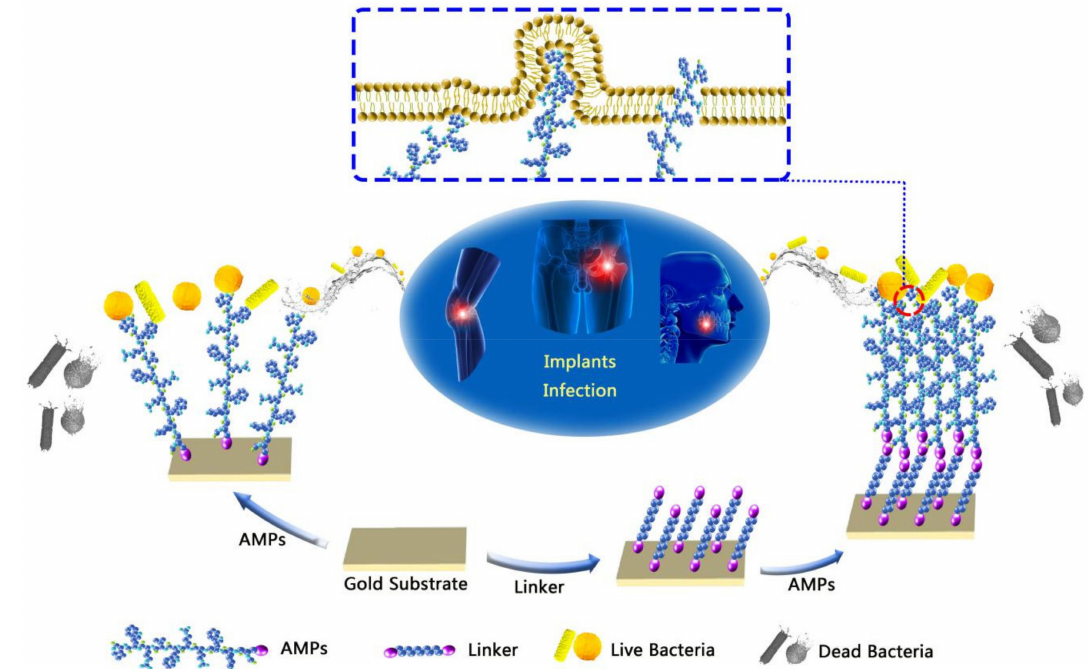
Figure 1. Schematic diagram of the structure of the AMPs and self-assembling processes on gold Scheme 6538. and E. coli (ATCC 44102) were used as a representative of Gram-positive and Gram-negative bacteria, to evaluate antimicrobial ability of AMP-functionalized